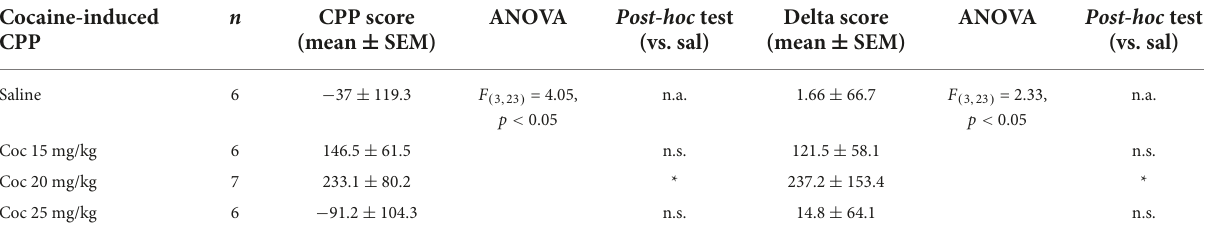
TABLE 2 Systemic (i.p.) administration of cocaine (20 mg/kg but not 15 or 25 mg/kg) supported the acquisition of cocaine-induced CPP after only one cocaine-chamber pairing. n CPP score Cocaine-induced ANOVA Post-hoc test Delta score CPP (mean ± SEM) (vs. sal) (mean ± SEM)